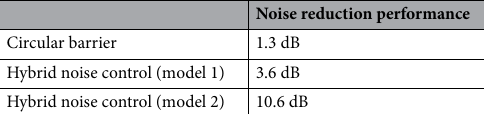
Table 1. Noise reduction performance in the experiment.